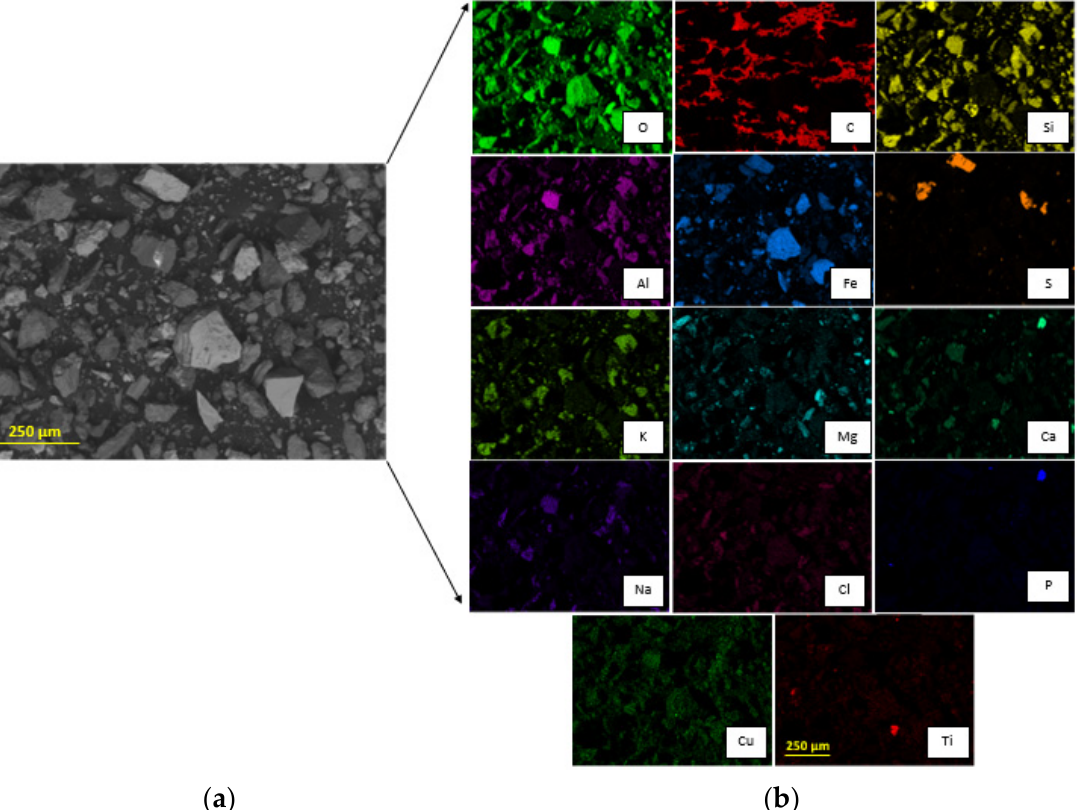
Figure 4. ( a ) SEM image and ( b ) EDX mapping of the tailing sample at 100× magnification.